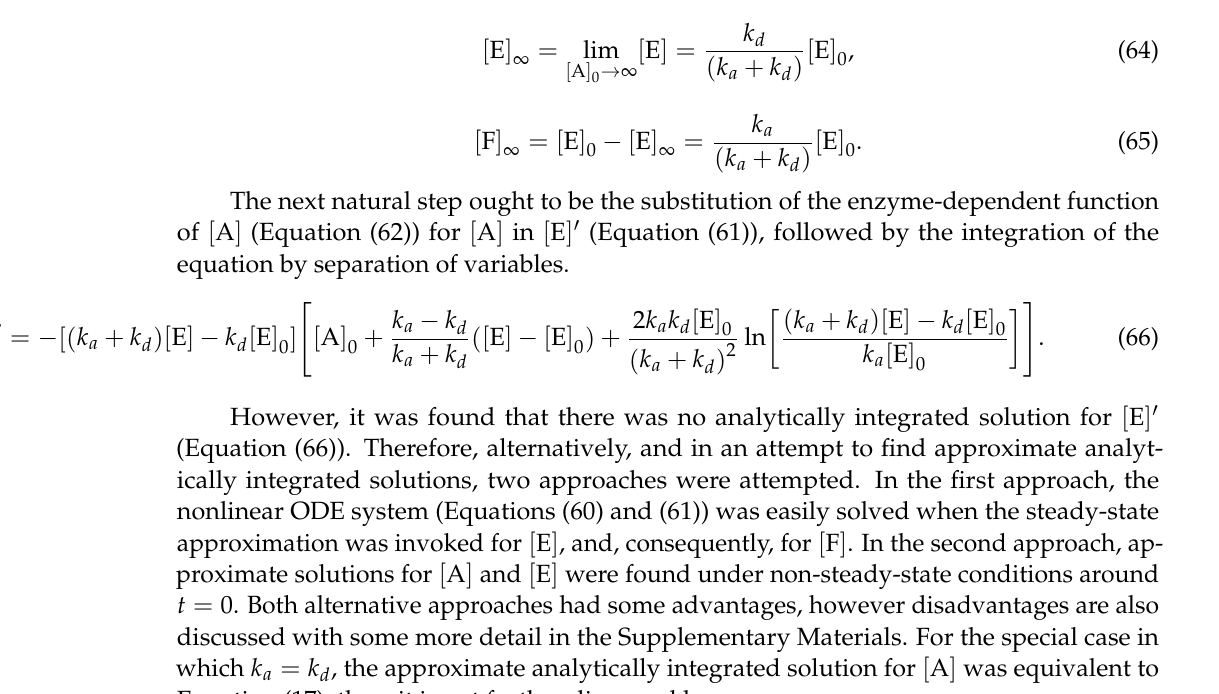
[A]  . The last domain corresponds with the region for which [E] and [F] were in a steady state and, hence, their rates approached zero (equations (S2) and (S3)). In this last domain, the time-dependent variation of [A] is an exponential function